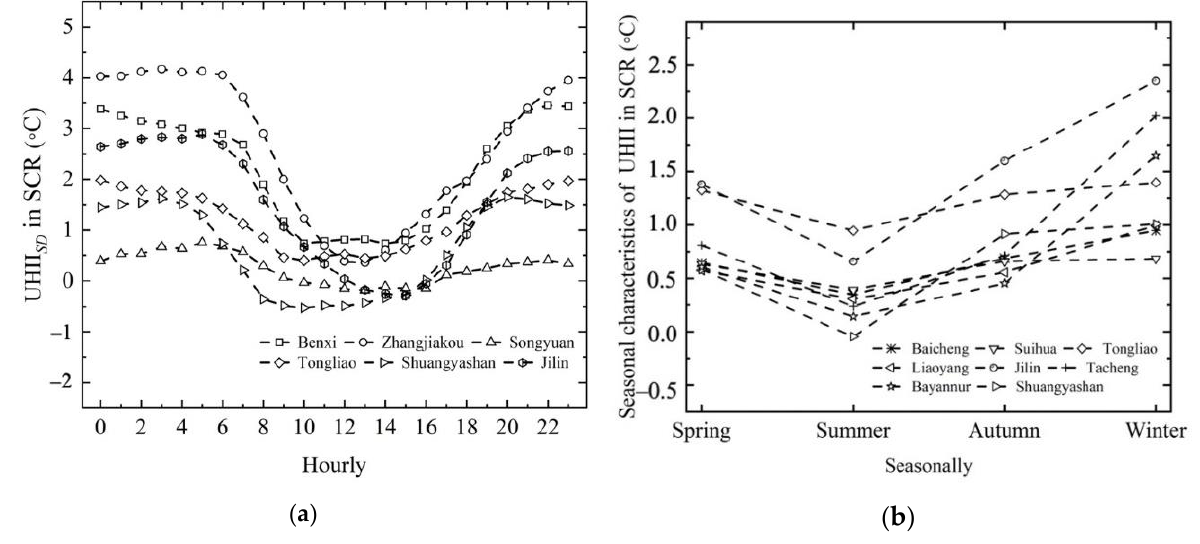
Figure 4. ( a ) UHII SD in typical SCR cities. ( b ) Seasonal mean UHII in typical SCR cities.